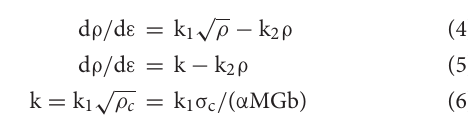
Frontiers in Materials |